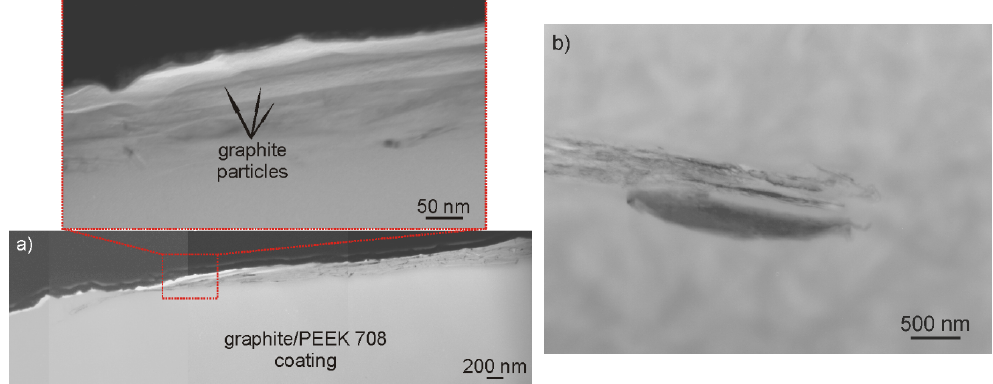
Figure 7. XRD patterns of the graphite/PEEK 708 as-deposited (1) and heat-treated (2) coatings on the Ti-6Al-4V alloy.